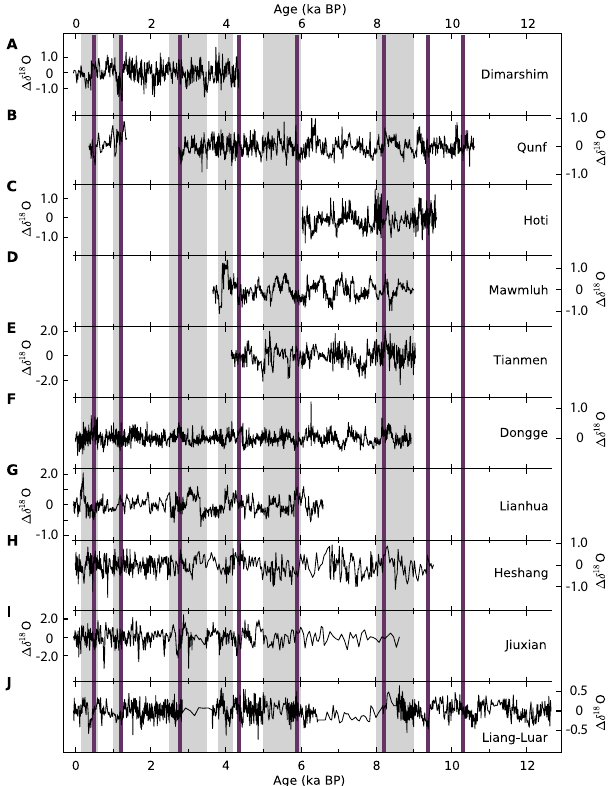
Figure 4. Residual oxygen isotope records (cid:49)δ 18 O analysed in this study (all measured in units of ‰ VPDB). The original records listed in Table 1 have been detrended using a 1000-year moving window (as in Donges et al., 2011a). Bond events (violet lines, Bond et al., 1997) and RCC episodes (grey bars, Mayewski et al., 2004) are displayed for reference.